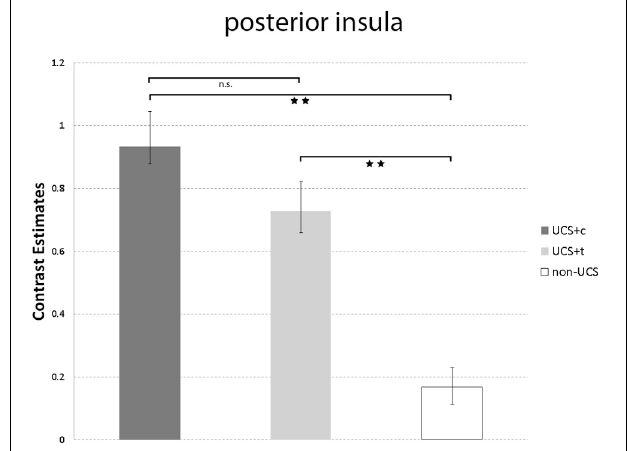
FIGURE 6 | Illustrated are the mean contrast estimates of the unconditioned responses UCS-c, UCS-t, and Non-UCS in the posterior insula. T-bars represent standard errors of the mean ( ± s.e.m.). ∗∗ p < 0 .